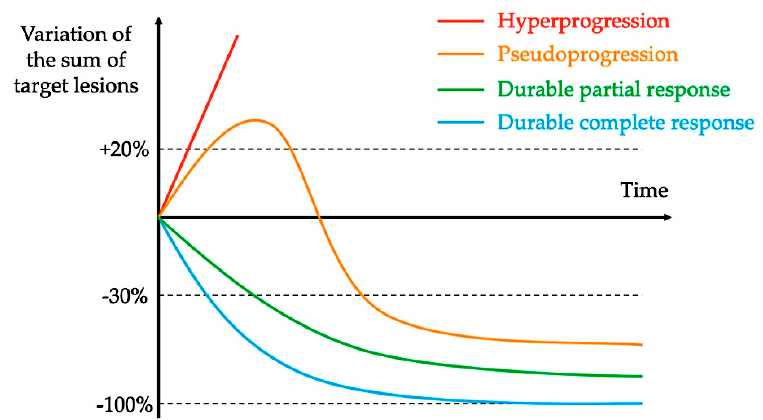
Figure 1. Examples of new patterns of response and progression with immunotherapy.